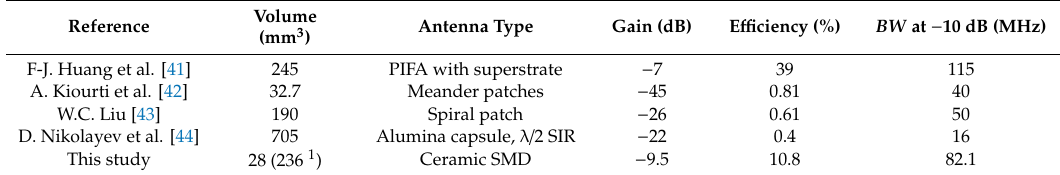
Figure 11. ( a ) Photography of the prototype manufactured for the antenna characterization, ( b ) measured reflection coefficient of the antenna in the phantom with and without the matching network. Table 1. Comparison with other antennas in the Medical Implant Communication Service (MICS) band reported in the